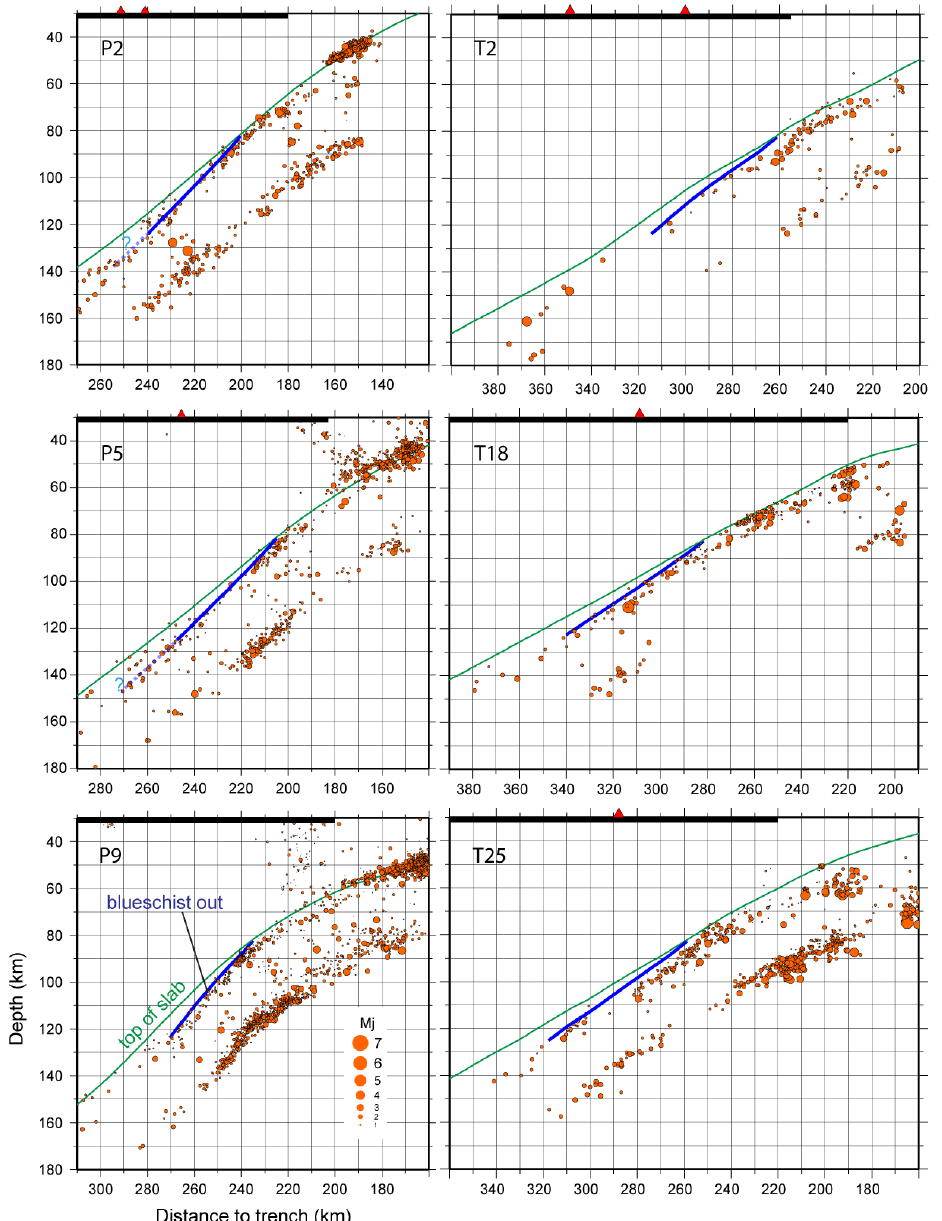
Fig. 5. Seismicity within 10km from cross section (orange circles) compared to the location of the blueschist-eclogite transition (blue line) from the thermal models of Tohoku (T2–T25) and eastern Hokkaido (P2–P9). The top of the slab is shown in the solid green line. Volcanoes (within 30km from cross section) are shown in red triangles. The furthest extent from coast line to coast line is indicated by the solid black bar at the top of each cross section. Dashed blue line in P2 and P5 is speculative extension of the blueschist-out boundary to below Moho